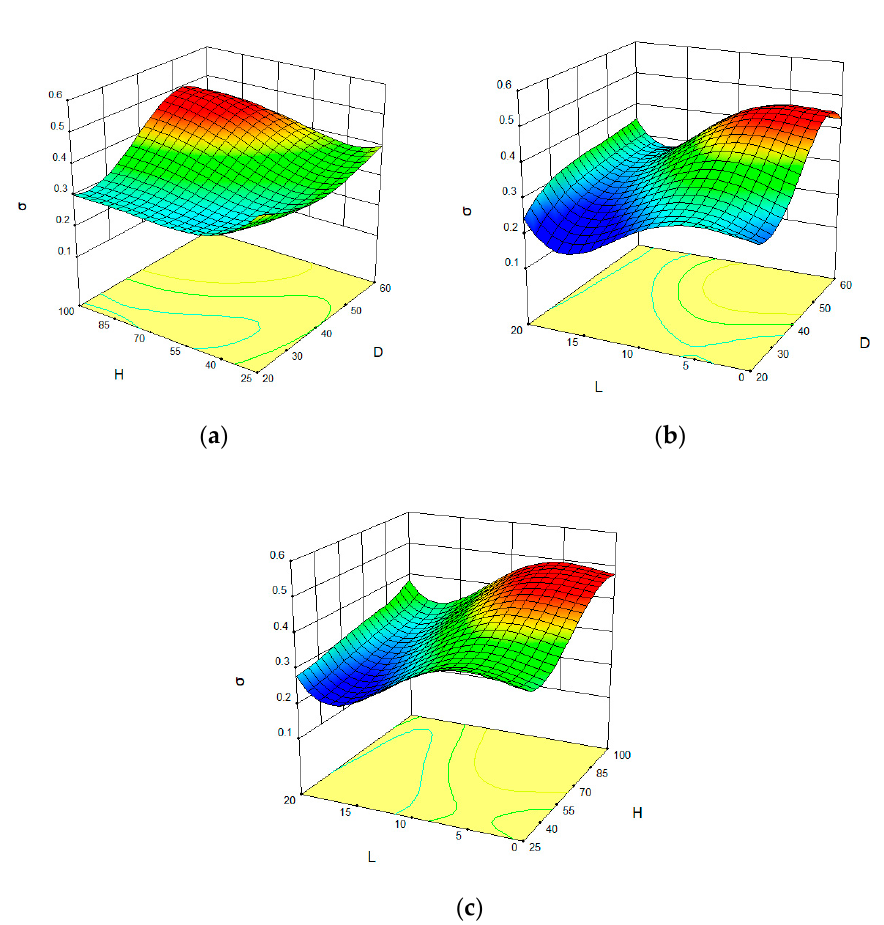
Figure 3. 3D plot of response surface for liquid maldistribution factor σ . ( a ) Throat diameter D and